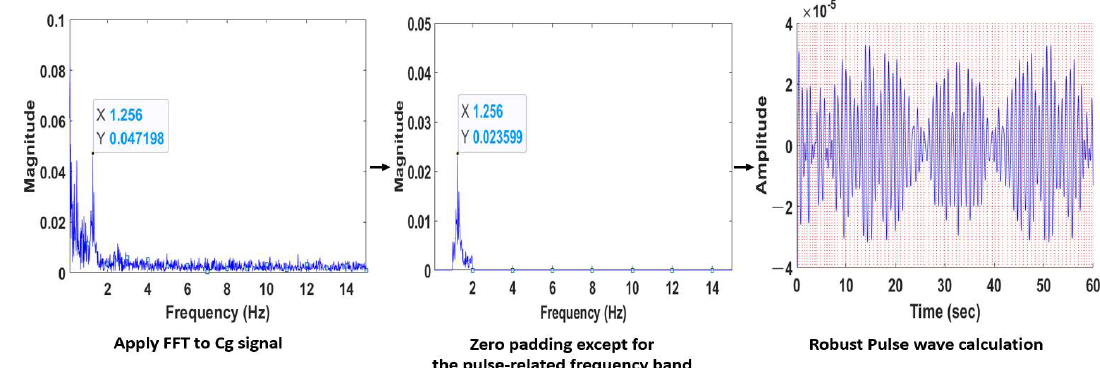
Figure 9. Process of the pulse wave extraction.